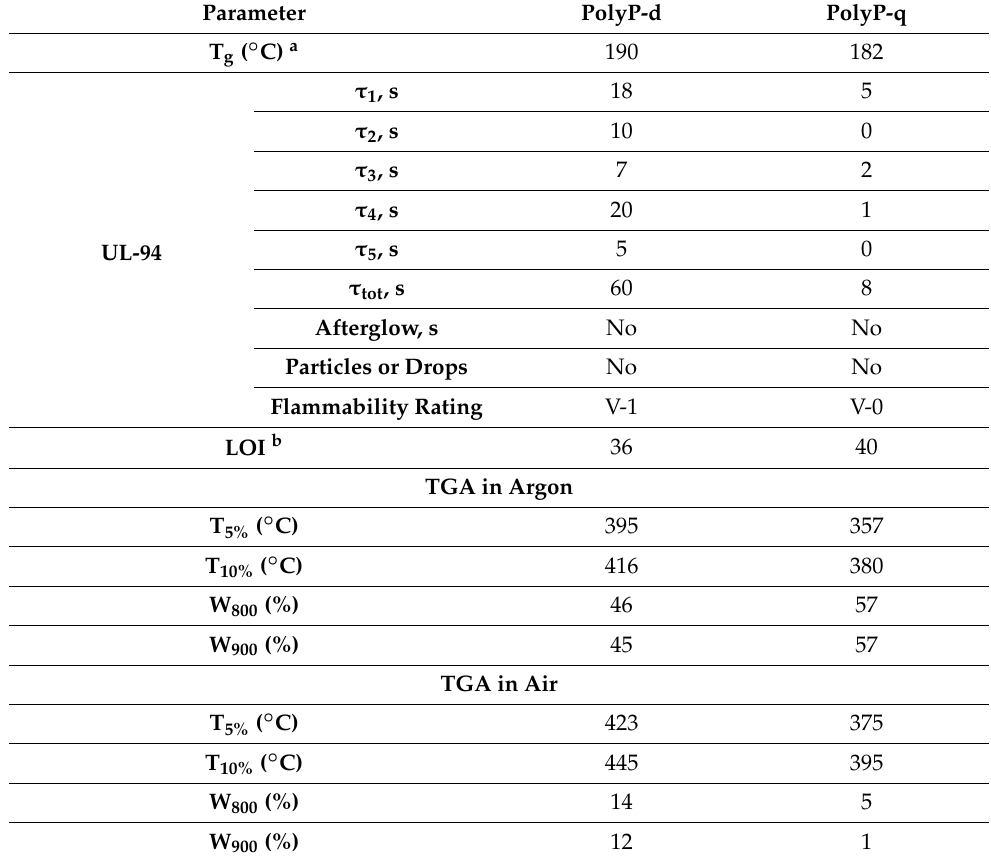
Table 6. Thermal properties of benzoxazines based on diamines.